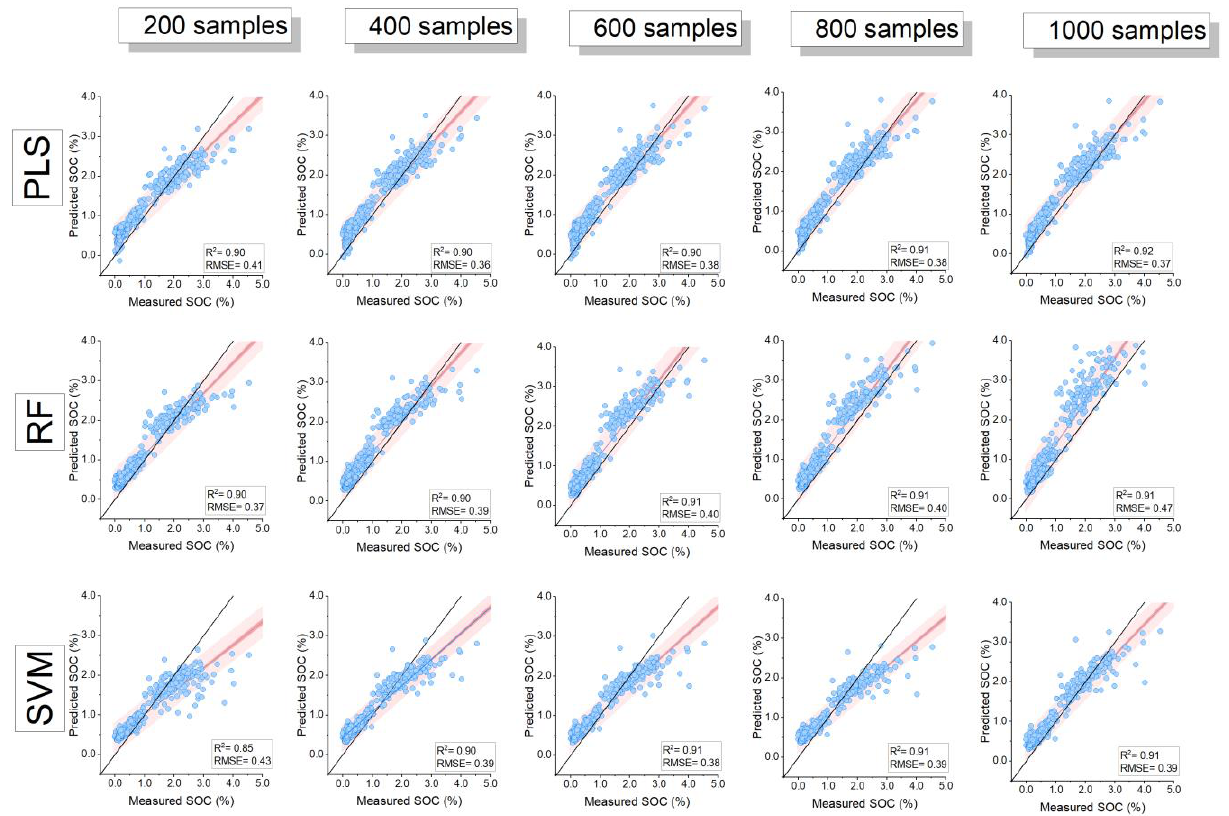
Figure 5. Comparison between the soil organic carbon (SOC) values measured by elemental analyses and the MID predicted values using the three different training algorithms, partial least squares (PLS), random forest (RF) and support vector machine (SVM). The validation included and external test set comprised of 612 observations. For each sample size, the graphs represent an average of the five calibrations randomly extracted from the total dataset (n = 1000 samples).